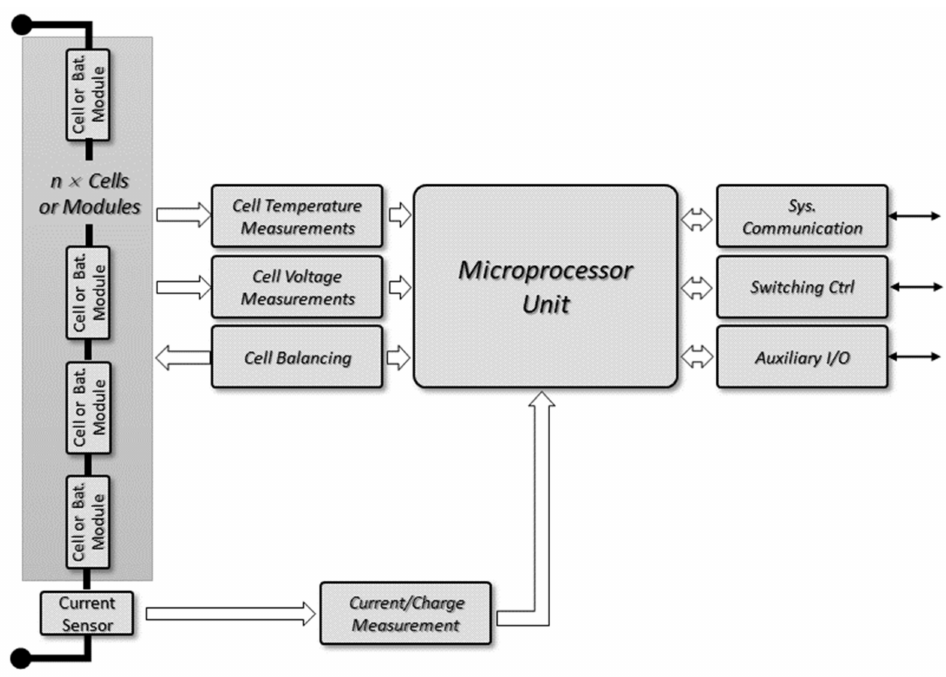
Figure 1. The structure of the static centralized Battery Management